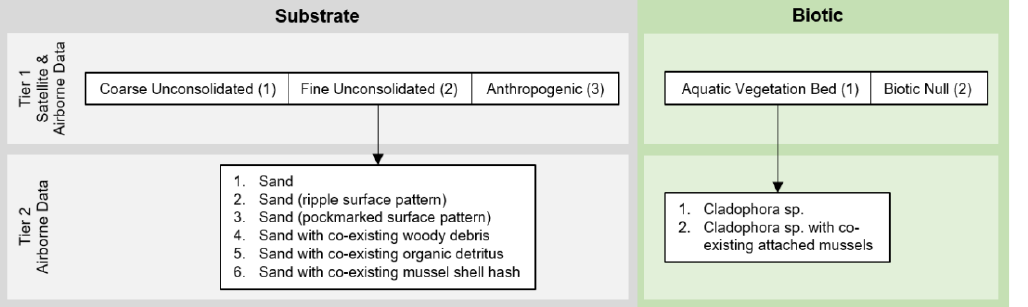
Figure 7. Underwater photo samples for Tier 1 substrate classes: ( a ) coarse unconsolidated, ( b ) fine unconsolidated, and ( c ) anthropogenic; Tier 2 fine unconsolidated substrate classes: ( d ) sand, ( e ) sand (ripple surface pattern), ( f ) sand (pock- marked surface pattern), ( g ) sand with co-existing woody debris, ( h ) sand with co-existing organic detritus, and ( i ) sand with co-existing mussel shell hash. Figure 8. Underwater photo samples for Tier 1 biotic classes: ( a ) aquatic vegetation bed and ( b ) biotic null; Tier 2 aquatic vegetation bed biotic classes: ( c ) Cladophora sp. and ( d ) Cladophora sp. with co-existing attached mussels.